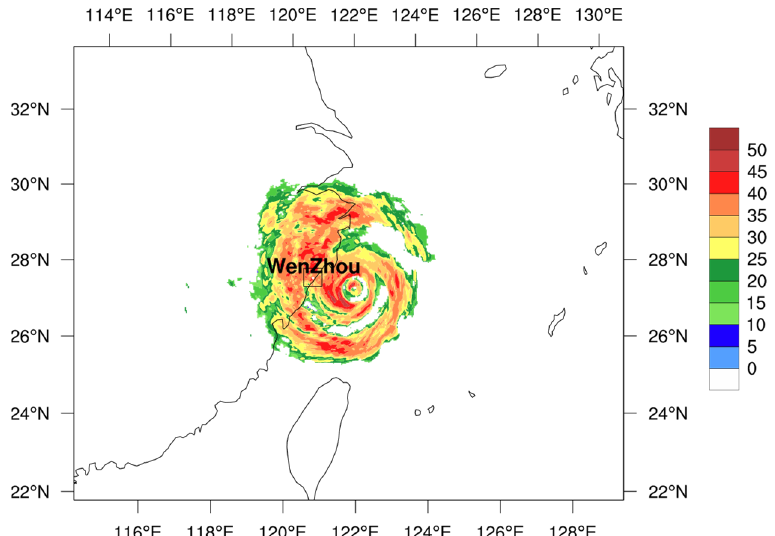
Figure 1. Domain of the WRF model at 3 km horizontal resolution with radar reflectivity observations (shaded; units: dBZ) at 1200 UTC, 9 August; the rectangle indicates the location of the Wenzhou radar station.